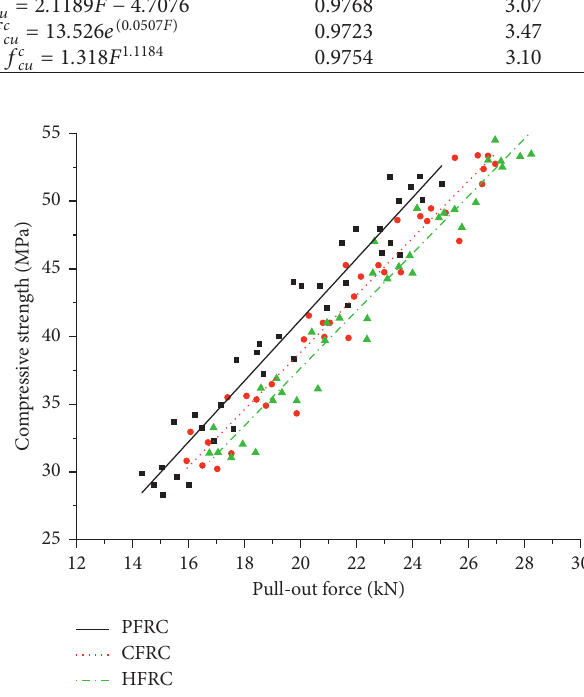
Table 12: Various regression models used to estimate the compressive strength of HFRC from postinstalled pull-out forces. Regression models